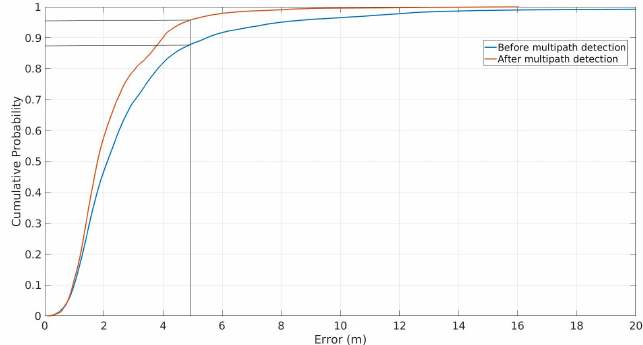
Figure 20. CDF (Cumulative Density Function) plot of localization error for the first experiment.